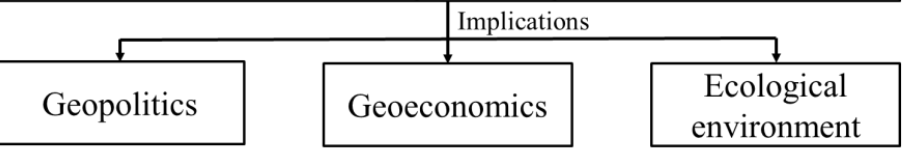
Table 2. The classification and description of